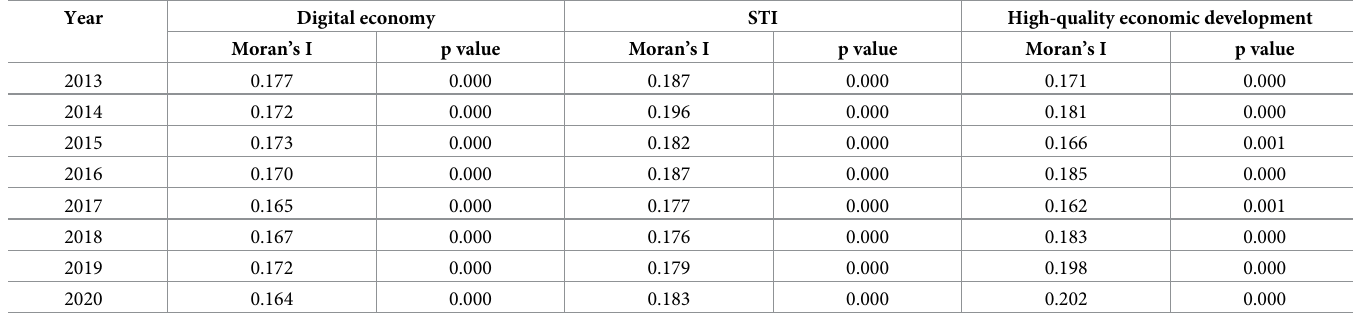
Table 6. Global Moran’s I